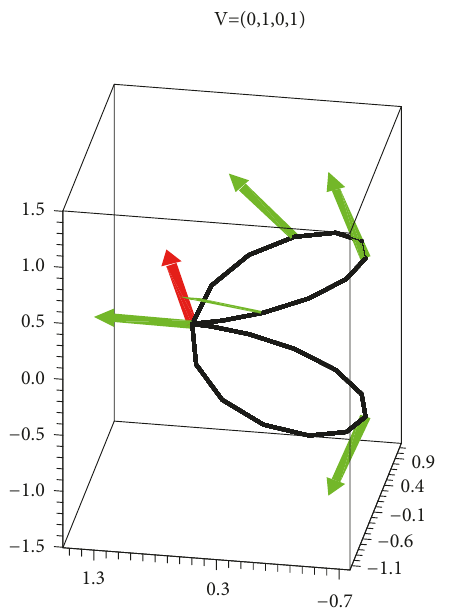
Figure 5: Red vector is 𝛾 󸀠 (0) = {2, 0, 1,0} , and green vectors are magnetic fields 𝑉 = (√2/2){0,1, 0,1} .